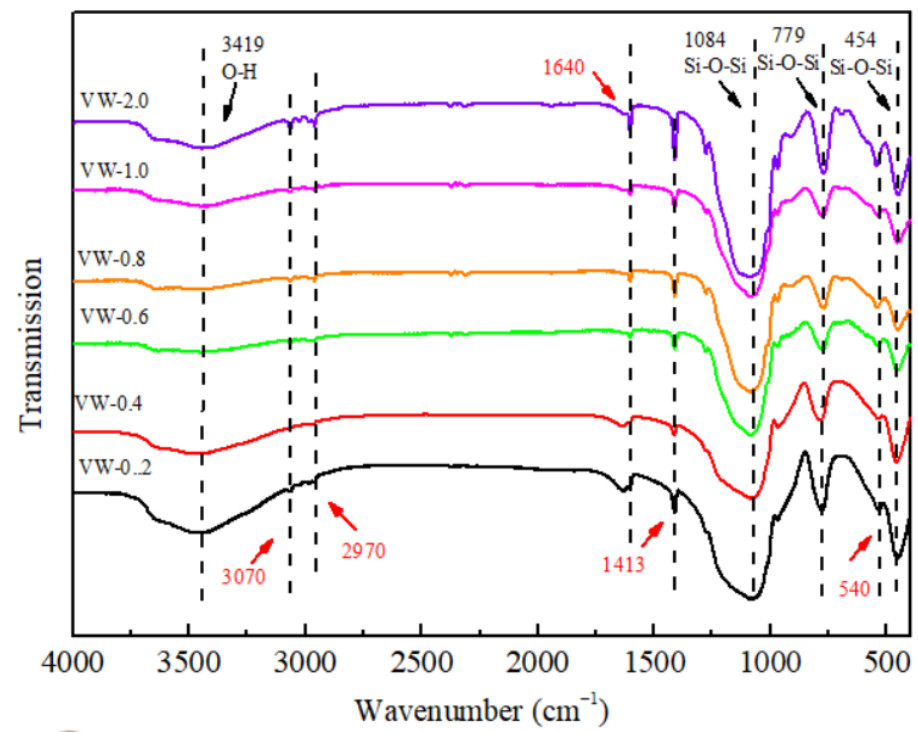
Figure 8. Fourier-transform infrared spectroscopy of the silica aerogel.